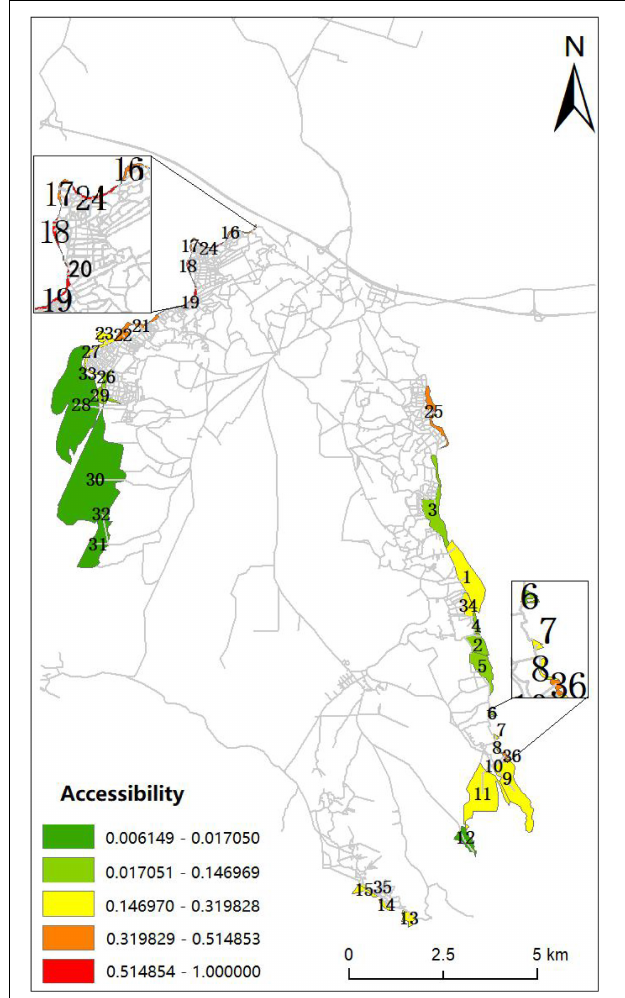
FIGURE 4 | Accessibility of the mangroves calculated by livelihood